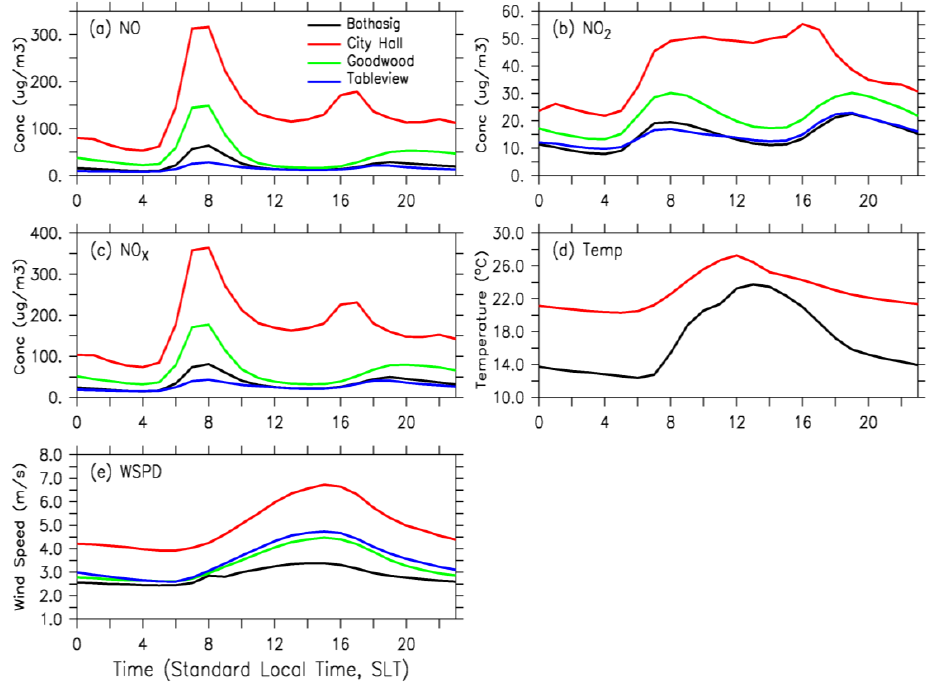
Fig. 4. Diurnal variation of observed (a) NO, (b) NO 2 , (c) NO x (d) temperature, and (e) wind speed at four monitoring stations in Cape Figure 4: Diurnal variation of observed (a) NO, (b) NO Town. The values are for all seasons speed at four monitoring stations in Cape Town. The values are for all seasons (2001-2008).